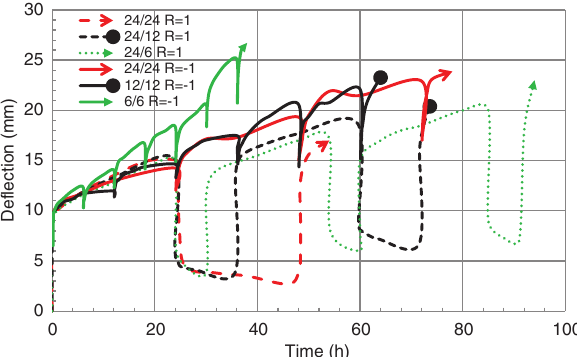
Figure 6: A comparison of R = 1 at fixed loading and various unloading times with R = -1 test results at equal loading and reverse loading times.